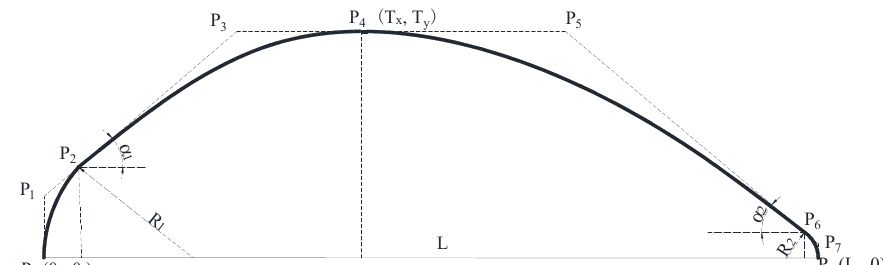
Figure 4. Half-thickness distribution curve parameterization.